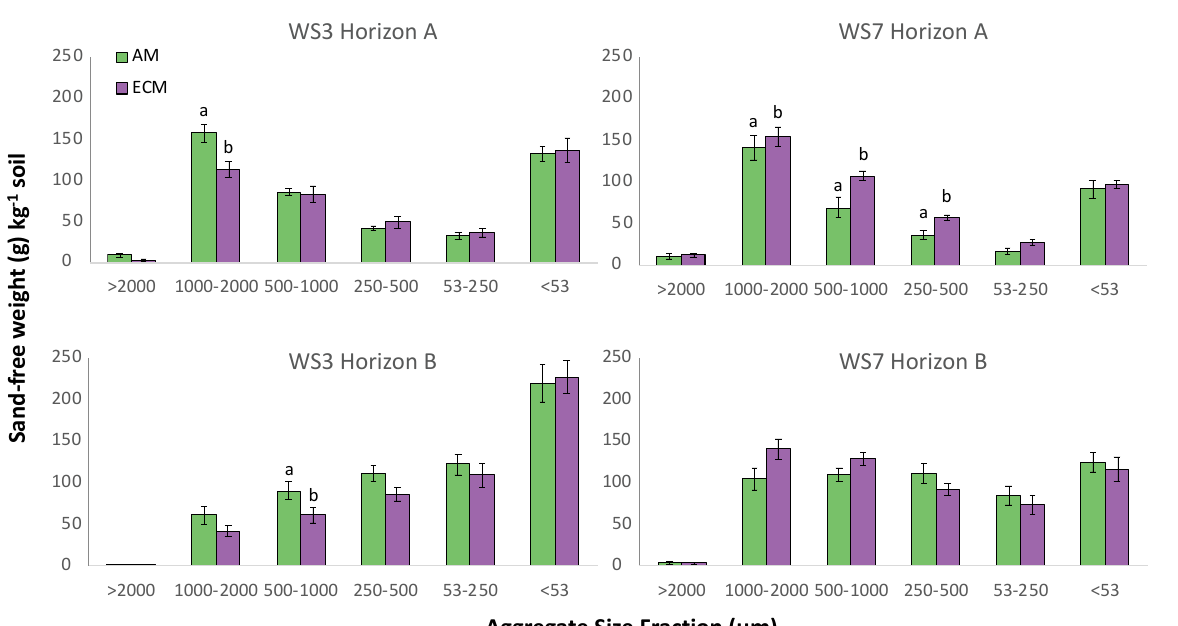
Figure 6. Sand-free weight within each aggregate size class by watershed (WS3-FERT and WS7-REF) in A-horizon and B-horizon: for each horizon, bars with different letters within each aggregate size fraction and watershed are significantly different according to Kruskal–Wallis means comparison ( p < 0.05).